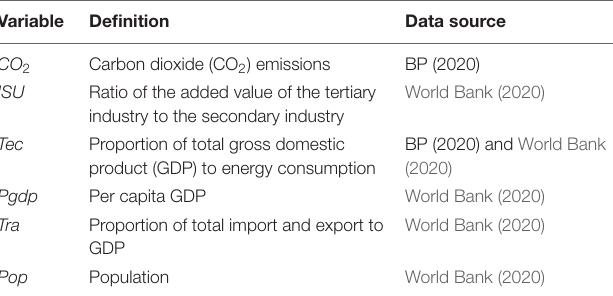
TABLE 1 | Description of all the selected variables.